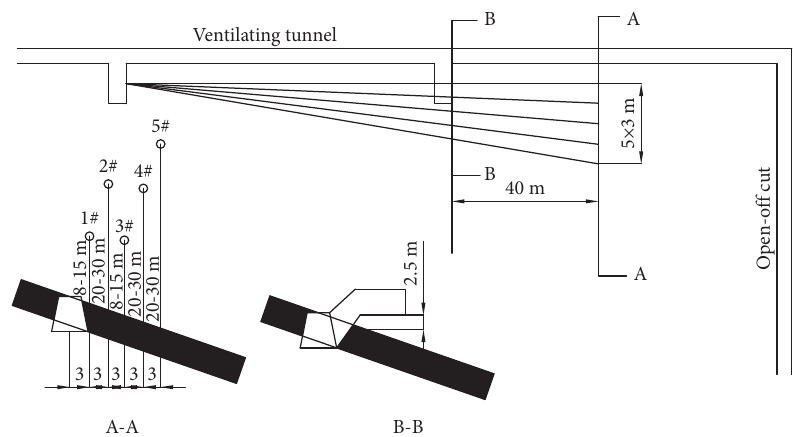
Figure 10: Roof borehole layout in No. 2 1024